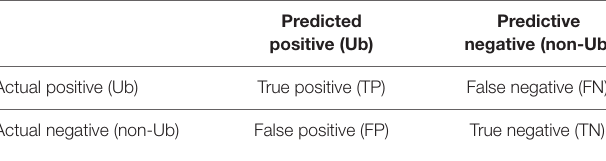
TABLE 1 | Confusion matrix of ubiquitylated site prediction